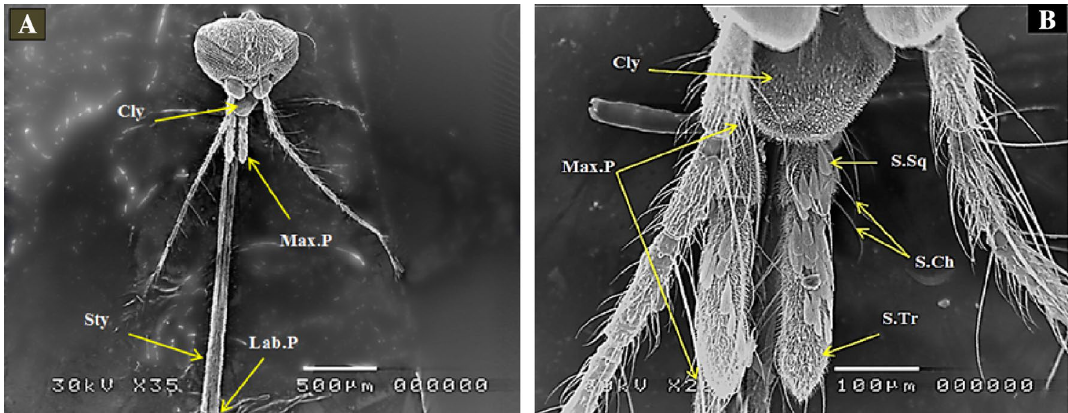
Figure 1. SEM photography of control female mosquito, Culex pipiens mouthparts (35 and 250×) showing ( A ) Clypeus (Cly), Stylets (Sty), Maxillary Palps (Max.P) and Labial Palps (Lab.P), ( B ) showing different types of sensilla; scales squamiformia (S.Sq), chaetica (S.Ch) and trichodea (S.Tr).